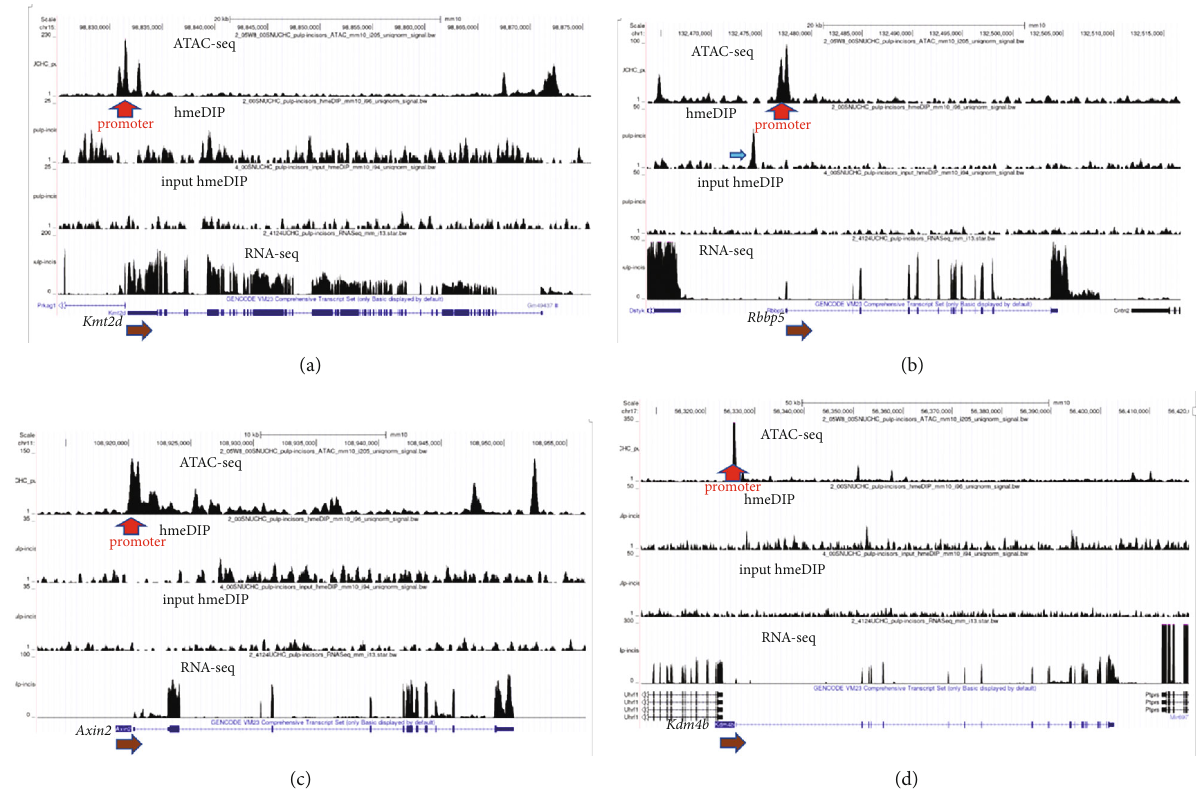
Figure 4: Chromatin structures of Kmt2d , Rbbp5 , Axin2 , and Kdm4b in the mouse incisor dental pulp. (a) ATAC-seq analysis indicated that the chromatin is accessible in Kmt2d. Strong peaks were detected in the transcription start site (TSS) marked with a red arrow. hmeDIP-seq results showed 5hmC enrichment in gene bodies (compare to the input), which correlates well with RNA expression. The brown arrow indicates the direction of transcription. (b) The hmeDIP-seq and ATAC-seq peaks are enriched in the promoter (blue arrow) and TSS (red arrow) of Rbbp5 . The brown arrow indicates the direction of Rbbp5 expression. (c) The ATAC-seq and hmeDIP-seq peaks are enriched in the gene body of Axin2 . A strong ATAC-seq signal was also detected in the TSS (red arrow). The direction of Axin2 expression is marked with a brown arrow. (d) A strong ATAC-seq peak is present in the TSS (red arrow) of Kdm4b . 5hmC is enriched within the gene body of Kdm4b . The brown arrow indicates the direction of Kdm4b